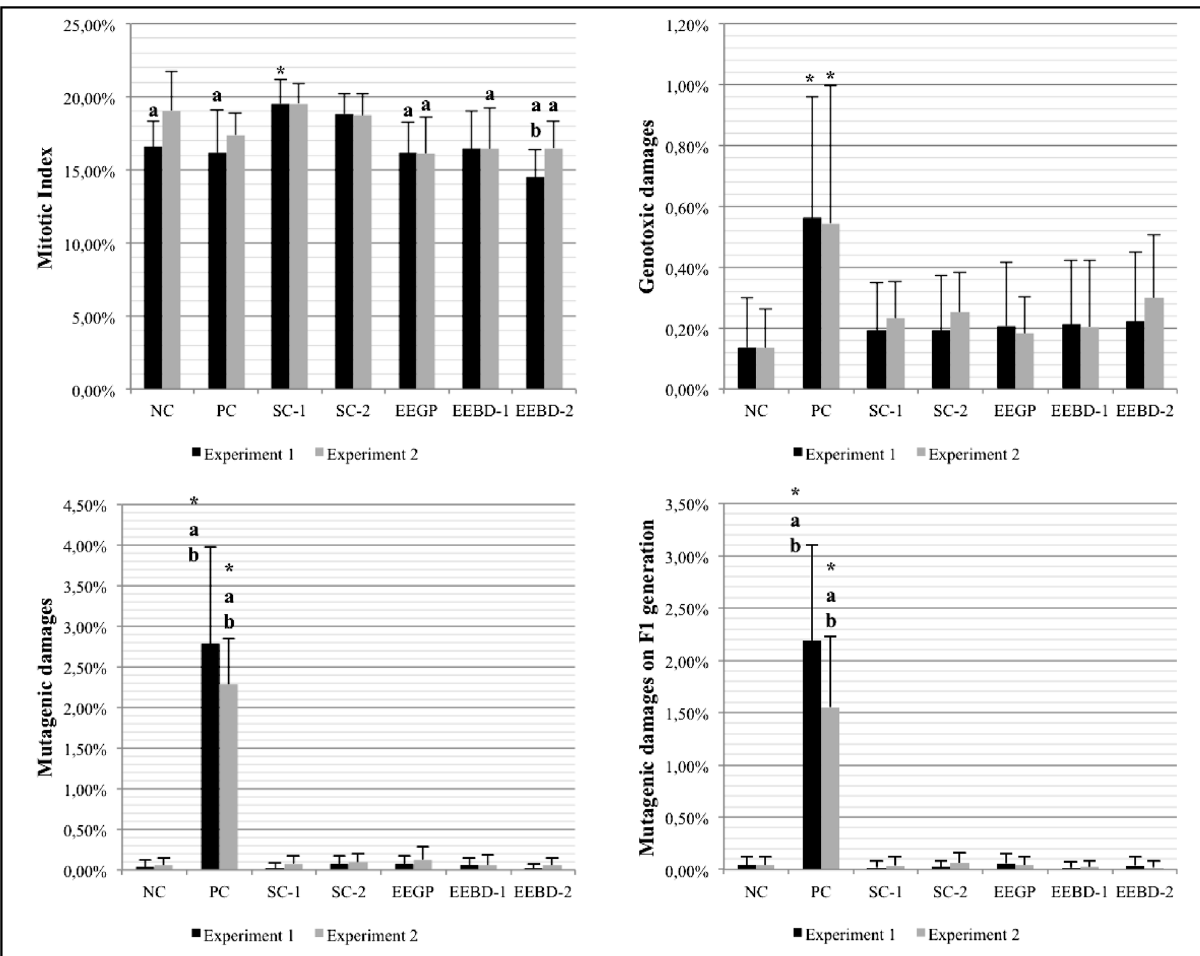
Figure 4 - Results obtained by the second collection of A. cepa roots, which were used to evaluate the anticytotoxic, antigenotoxic and antimutagenic po- tential of the ethanolic extracts (clastogenic treatment with methyl methanesulfonate - MMS). NC: negative control; PC: positive control; SC-1: solvent control 1 (ethanol - 0.042 (cid:2) L/mL); SC-2: solvent control 2 (ethanol - 0.21 (cid:2) L/mL); EEGP: ethanolic extract of Brazilian green propolis; EEBD-1: ethanolicextractof Baccharisdracunculifolia (0.06 (cid:2) L/mL);EEBD-2:ethanolicextractof Baccharisdracunculifolia (0.30 (cid:2) L/mL).* ,a,b Statisticallysig- nificant when compared to the NC, SC-1 and SC-2, respectively, by the Kruskal-Wallis/Dunn’s test (p <